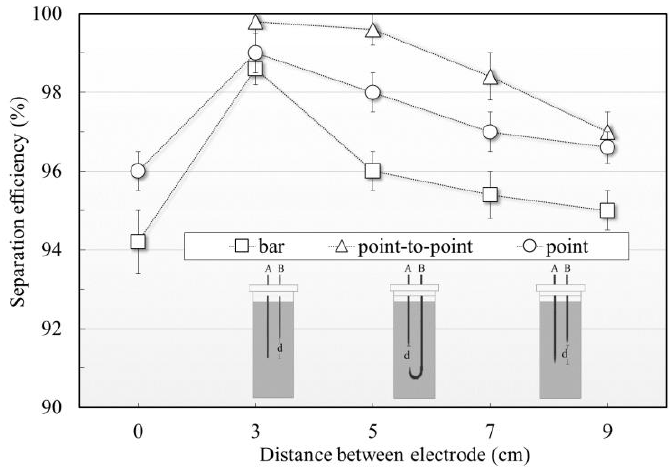
Figure 9. Effect of vertical distance between electrodes (d) with different electrode configurations on separation efficiency of EDS process using iron (Fe) electrodes with applied AC voltage of 3 kV for a separation time of 240 s. (A = High voltage electrode and B = Ground electrode)